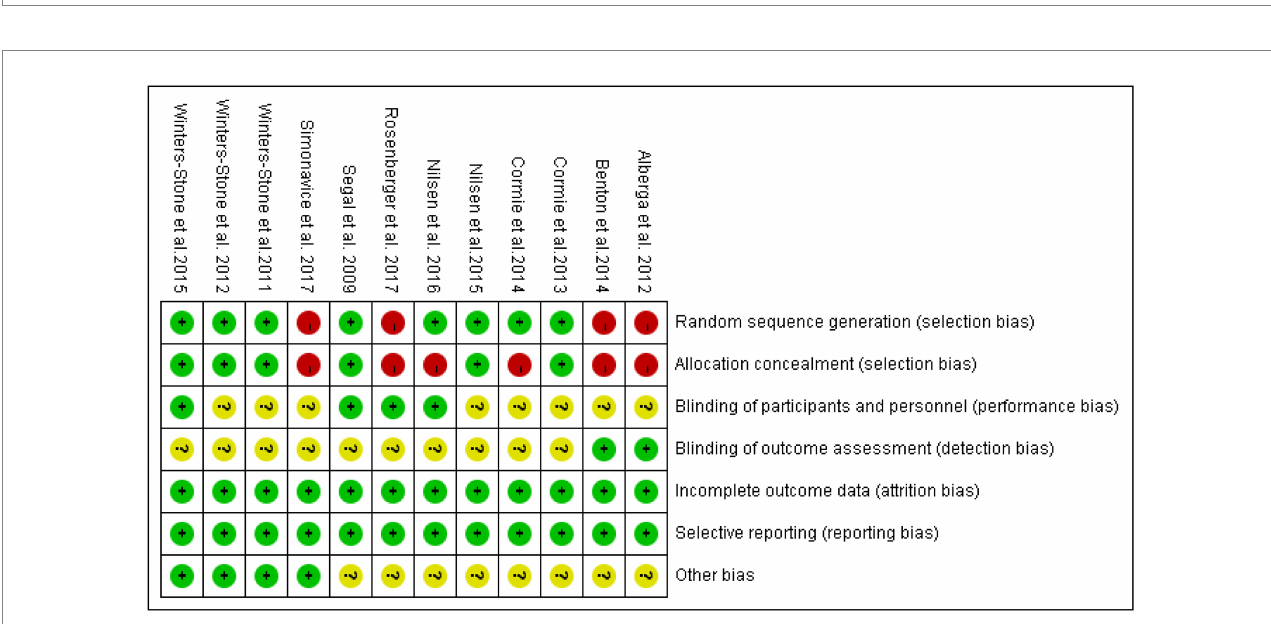
FIGURE 3 Diagram of the included literature with quality assessment. Green represents low risk, yellow represents unclear risk, red represents high risk.